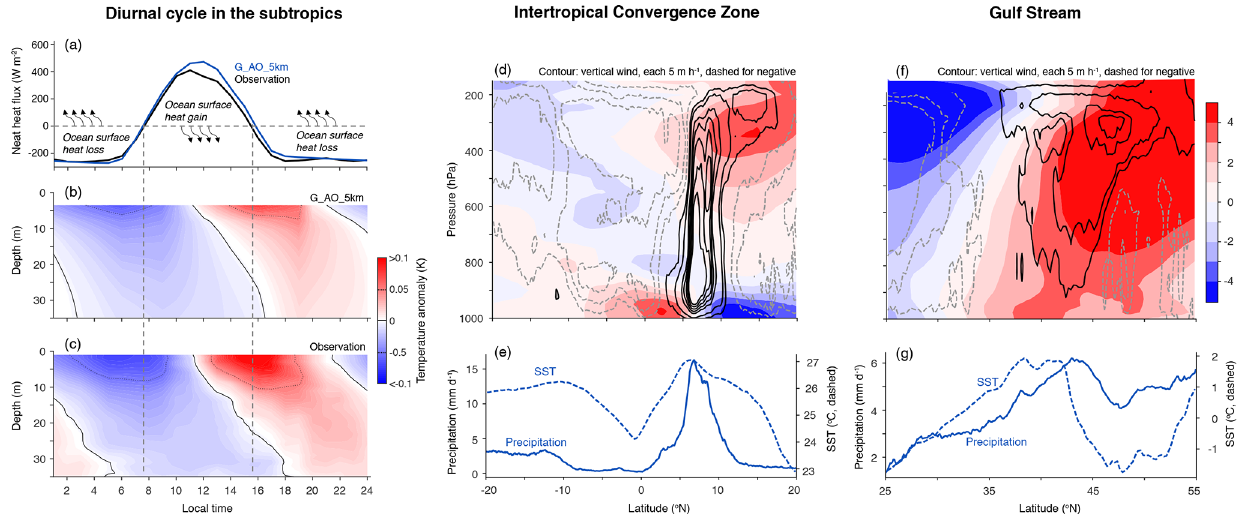
Figure 11. (a–c) Composite diurnal cycle of the upper-ocean daily temperature anomaly in G_AO_5km as well as in observations with associated net heat flux at the ocean surface. Observations are from ship data for the net heat flux and from three Slocum gliders for the temperature. Observations and G_AO_5km are averaged between 57–58 ◦ W and 11.5–14. ◦ N and from 21 January–29 February 2020. Panel (d) shows meridional cross-sections of wind together with meridional variations in SST and precipitation in (e) from G_AO_5km averaged over February 2020 through the central–eastern Pacific ITCZ. Panels (f) – (g) are like panels (d) – (e) but over the Gulf Stream. In (g) the SST Equator-to-pole meridional gradient is removed. Zonal averages are taken between 150 and 90 ◦ W in (d) – (e) and between 60 and 20 ◦ W in (f) – (g)